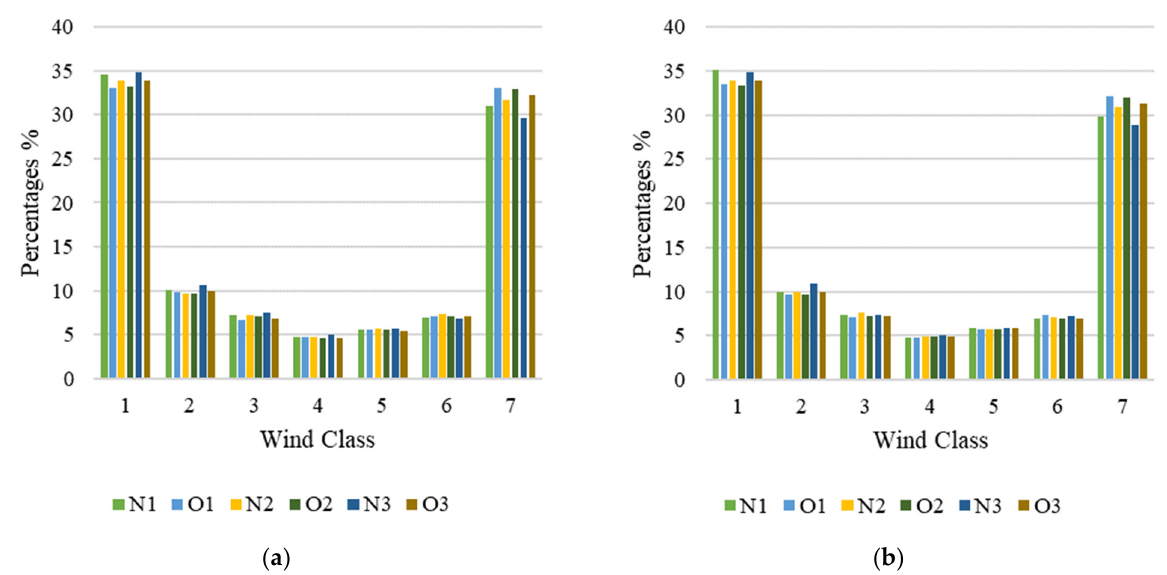
Figure 3. The distribution of the wind at the height of 90 m ( a ) near future; ( b ) distant future.